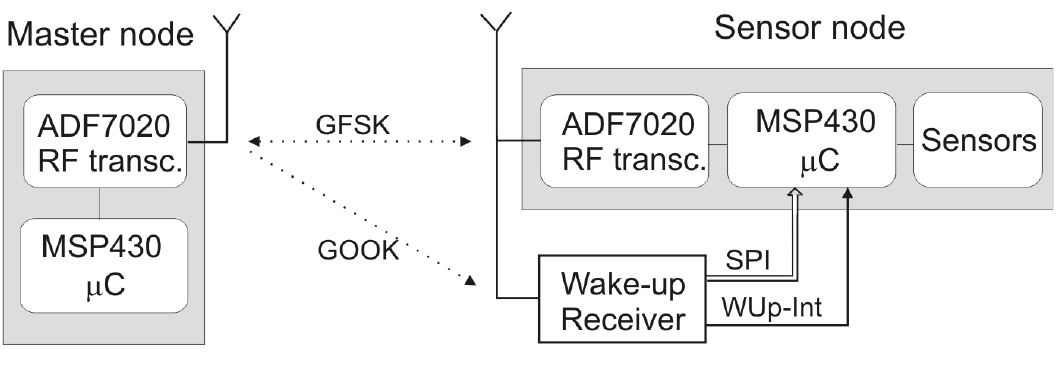
Figure 2. Wake Up Receiver